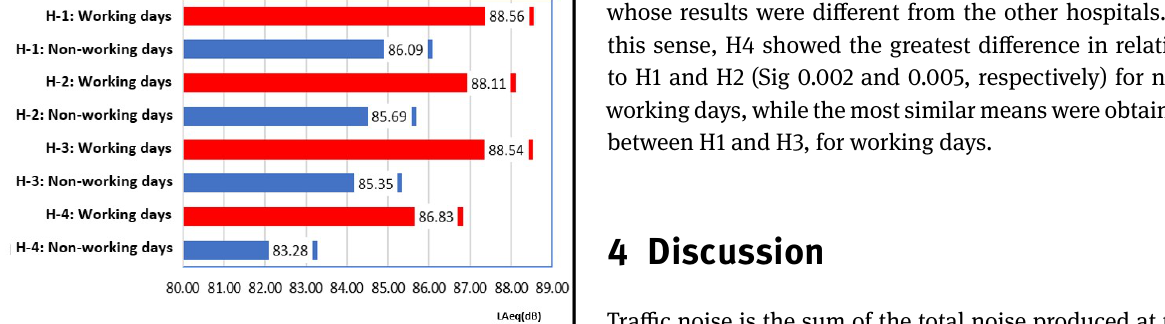
Table 2: Results of the statistical T test of comparison of the average values of each hospital on working and non-working days Bilateral significance Pairs of hospital Working